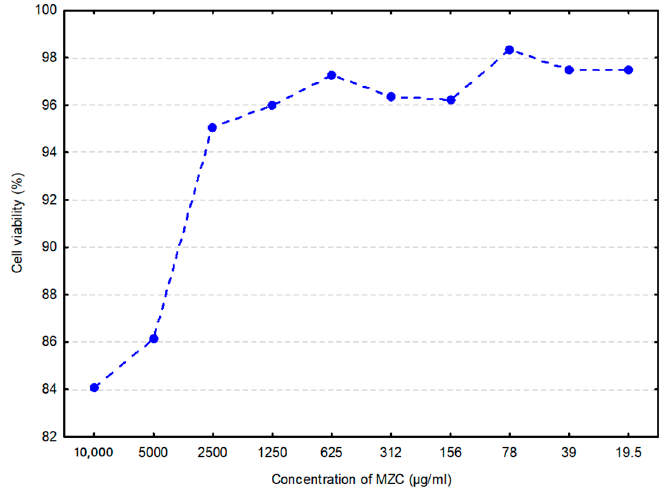
Figure 1. Cell viability of bovine intestinal epithelial cells (BIECs) when treated with zeolite clinoptilolite (MZC) (arithmetic mean of three replications) is shown as a percentage of the negative control. Cells in the culture medium represented the negative control.